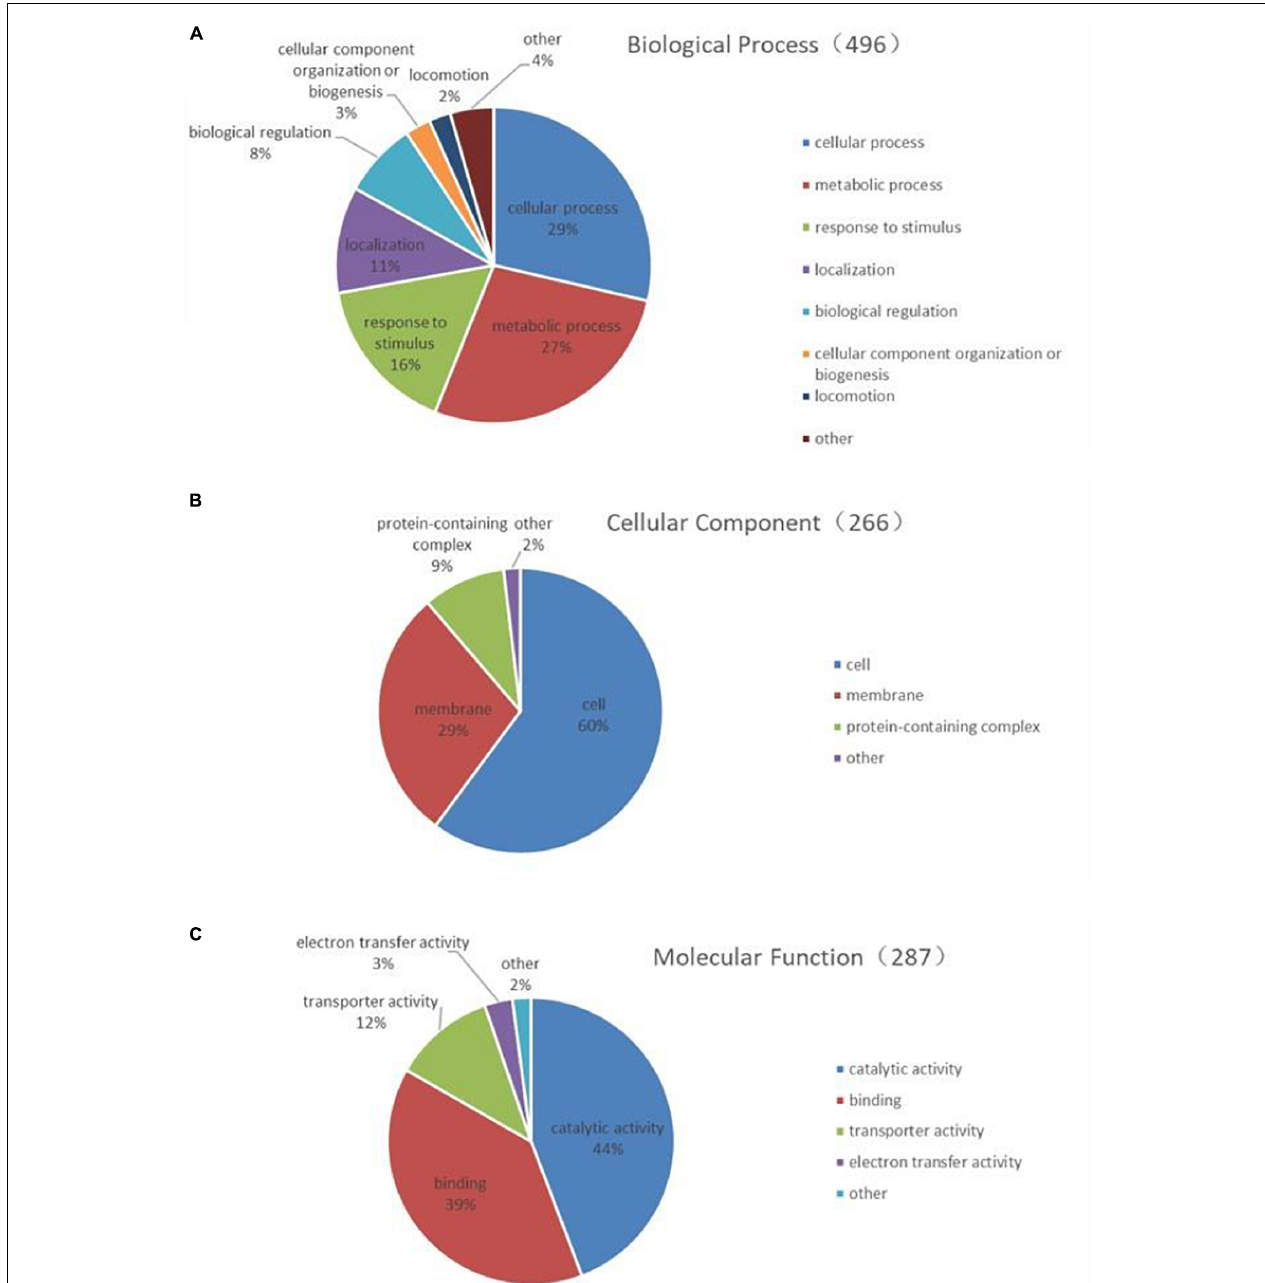
FIGURE 2 | Functional classification of differentially expressed proteins (A) biological process, (B) cell composition, and (C) molecular function.